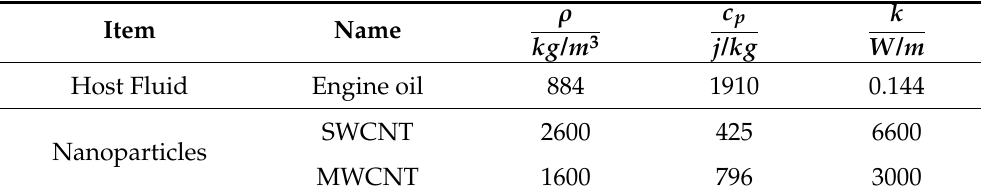
Table 1. Thermal properties of engine oil and CNTs (SWCNT/MWCNT)